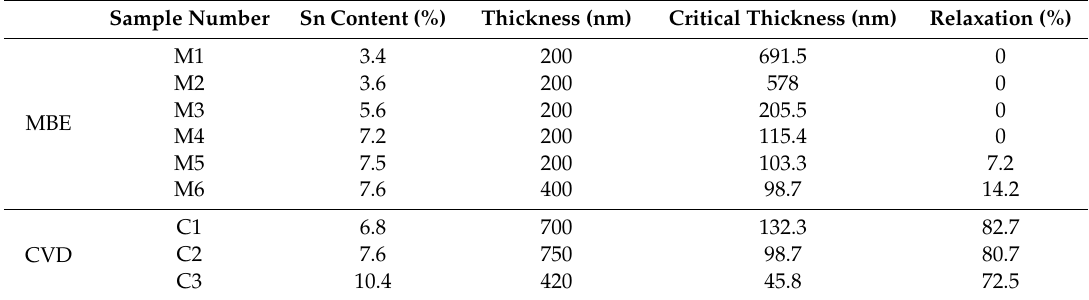
Figure 1. The sample structures of GeSn thin films grown by MBE ( a ) and CVD ( b ), respectively. Table 1. The Sn content, thickness, calculated critical thickness and degree of strain relaxation of the GeSn epilayers grown by MBE and